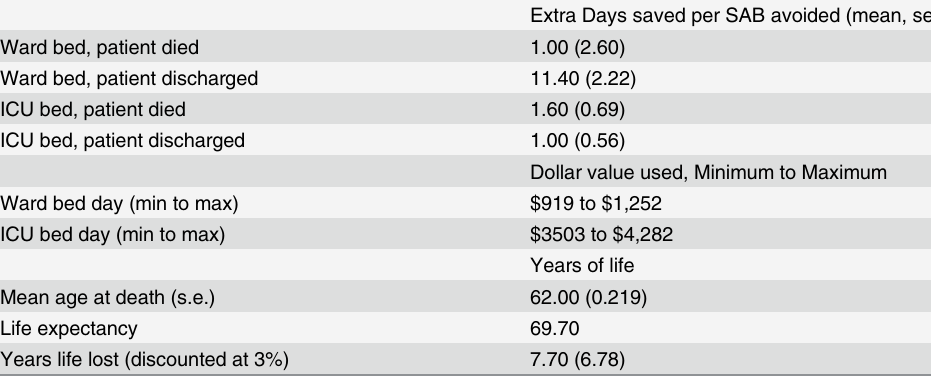
Table 2. Values used to estimate cost savings and years of life gained per Staphylococcus aureus bacteraemia avoided.